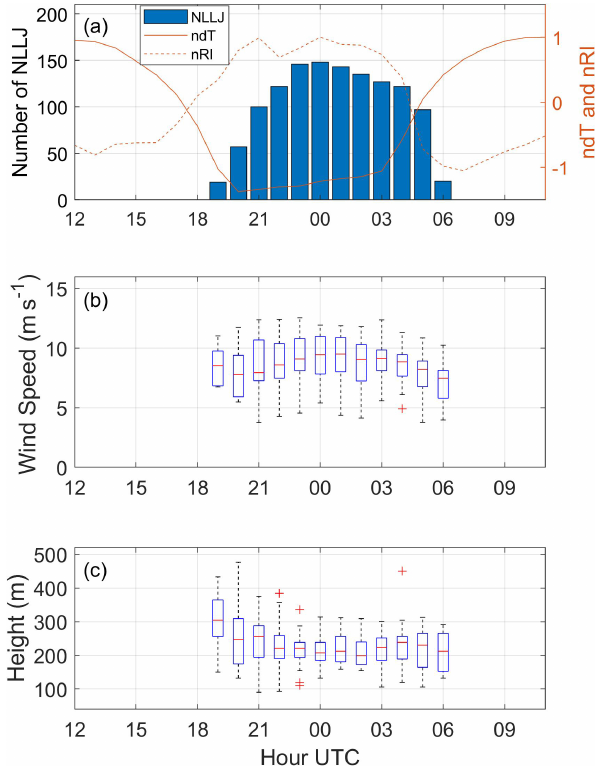
Figure 11. Daily cycle of NLLJs in Falkenberg. Shown are (a) the number of long NLLJs per hour, (b) their core wind speed and (c) their core height. Lines in (a) show the hourly averaged and normalized Ri (n Ri ) and dT (n dT